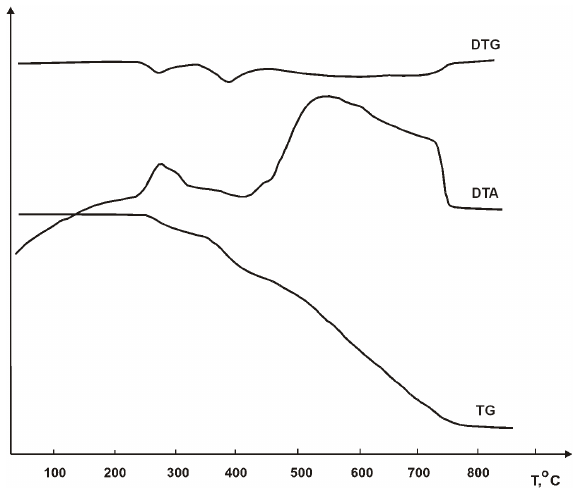
Fig. 4 Thermogram corresponding to the Sample 1 (TG = thermogravimetry; DTA = differential thermal analysis; DTG = derivative thermogravimetry).